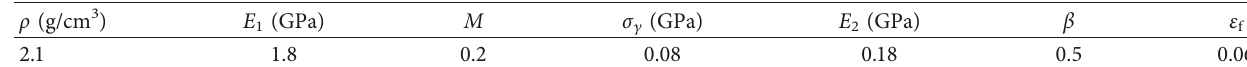
Table 5: Material parameters of the red sandstone [7, 25].